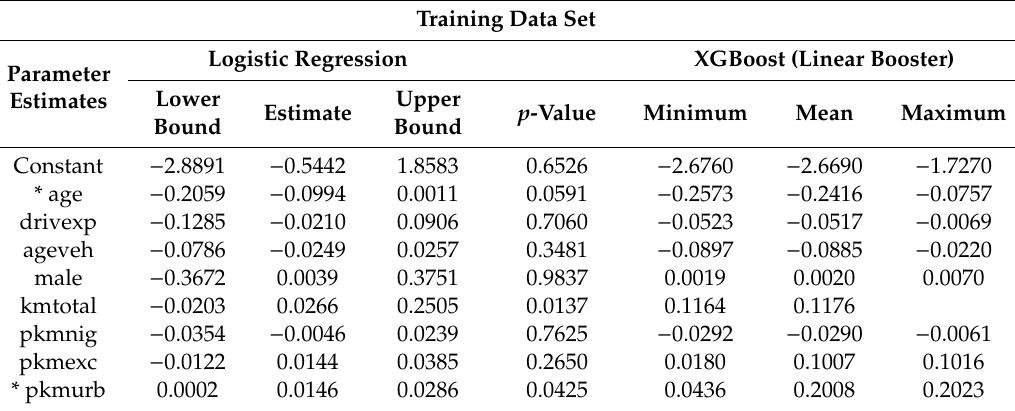
Table 2. The parameter estimates of the logistic regression and XGBoost with linear booster.